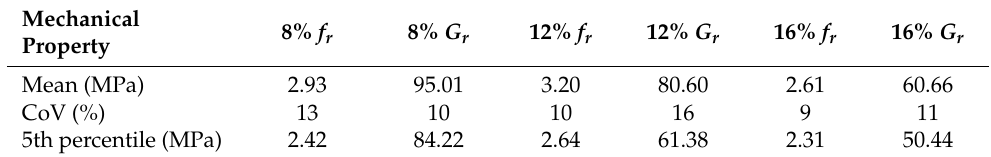
Table 2. Rolling shear modulus ( G r ) and strength ( f r ) of southern pine with varying moisture